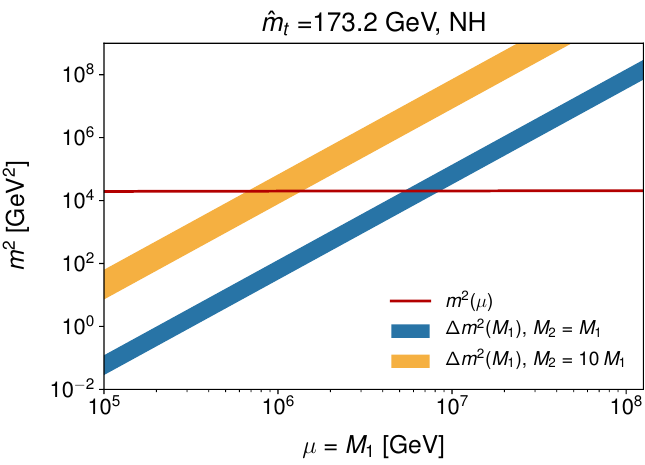
Figure 3 . Numerical comparison between the values of the threshold correction (cid:1) m 2 ( M 1 ) com- patible with neutrino physics constraints in the degenerate M 1 = M 2 case (blue band) and when M 2 = 10 M 1 (orange band) with the running Higgs mass m 2 ( (cid:22) ) determined by the SM RGE and the measured SM parameters (red line). The running e(cid:11)ect is not appreciable in the scale shown because m 2 ( (cid:22) ) varies vary little compared to (cid:1) m 2 ( M 1 ). This plot assumes normal ordering of neutrino masses (NH) and ^ m t = 173 : 2